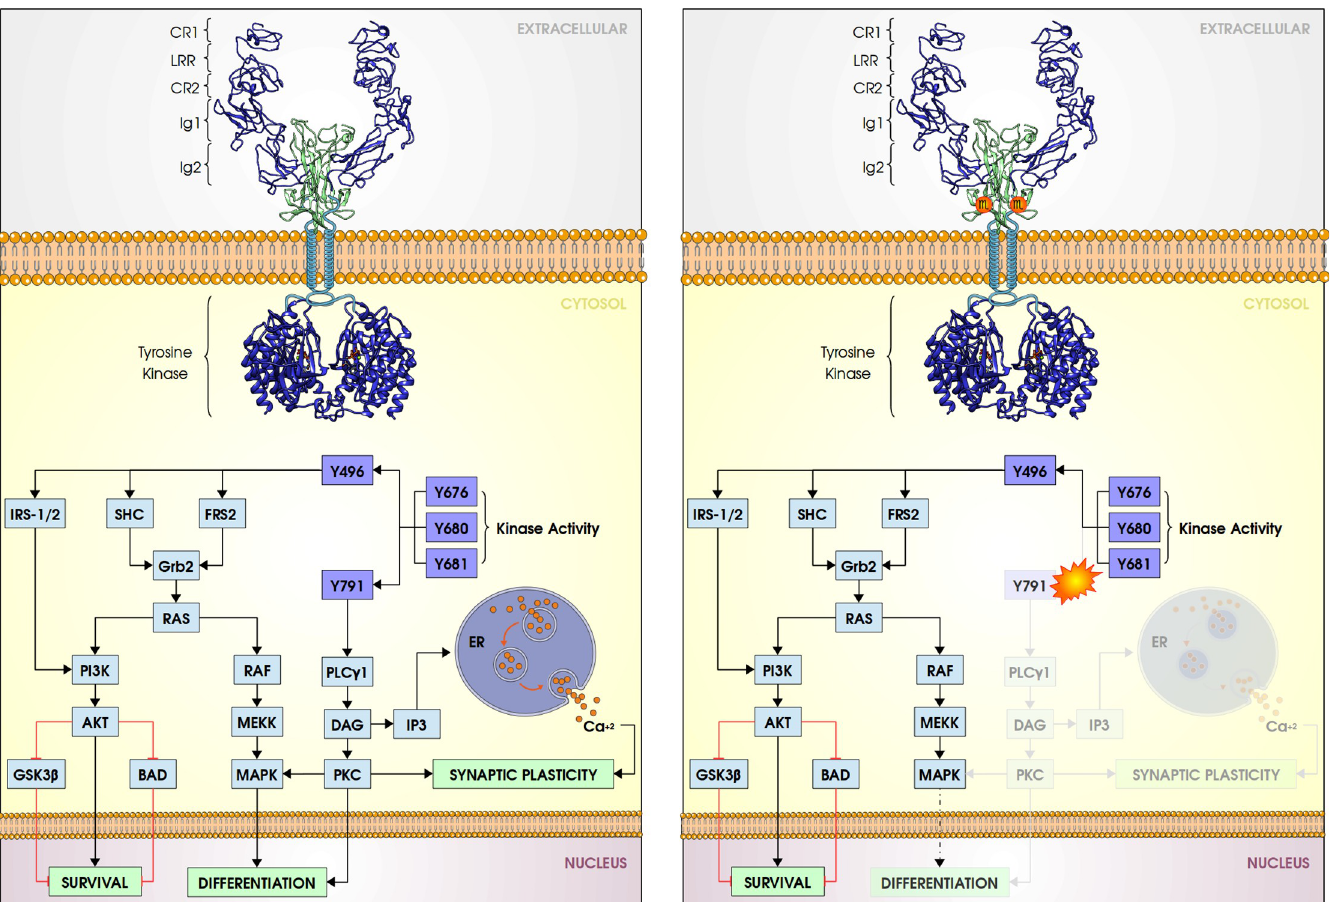
Fig 3. TrkA intracellular signaling activated by wild type and mutant NGF. (Left panel) Wild type signaling. NGF (green cartoon) promotes TrkA (blue cartoon) signaling mediated by phosphorylation of intracellular tyrosine residues (dark blue boxes). Phosphorylated Y496 forms an adaptor binding site that couple mitogen- activated protein kinases (MAPKs) and phosphoinositide 3-kinase (PI3K) signaling pathways, activating transcription of genes related to neuronal differentiation and survival, respectively. Phosphorylation of Y791 activates phospholipase C γ 1 (PLC γ 1) pathway, that mediates neuronal differentiation and synaptic plasticity via PKC and Ca +2 cytosolic release, respectively. Autophosphorylation of residues Y676, Y680 and Y681 mediates TrKA kinase activity and modulates Y496 and Y791 signaling. (Right panel) R221W mutant signaling. R221W mutation (orange spheres in NGF cartoon) incapacitates the induction of Y791 signaling pathway, impairing neuronal differentiation and synaptic plasticity, that results in the insensitivity to pain, heat and cold in HSAN5.